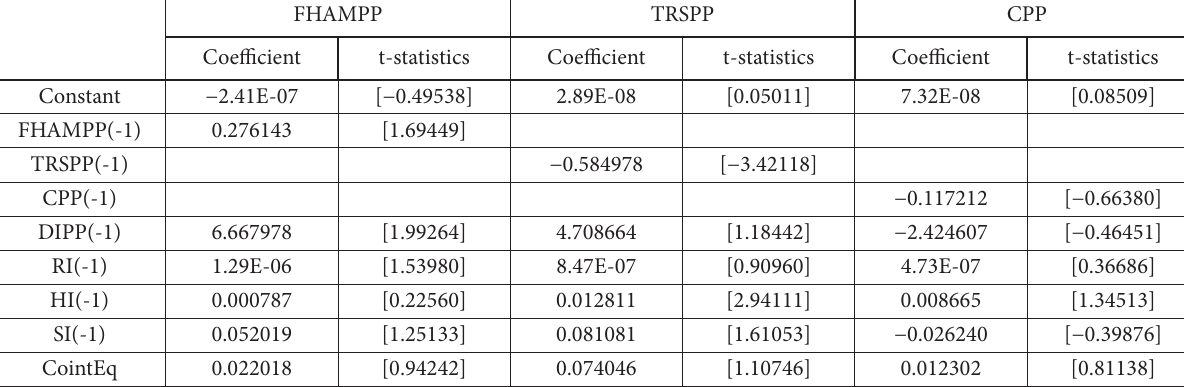
Table 10. Vector error correction model for sub-categories of durable goods consumption (short-term error